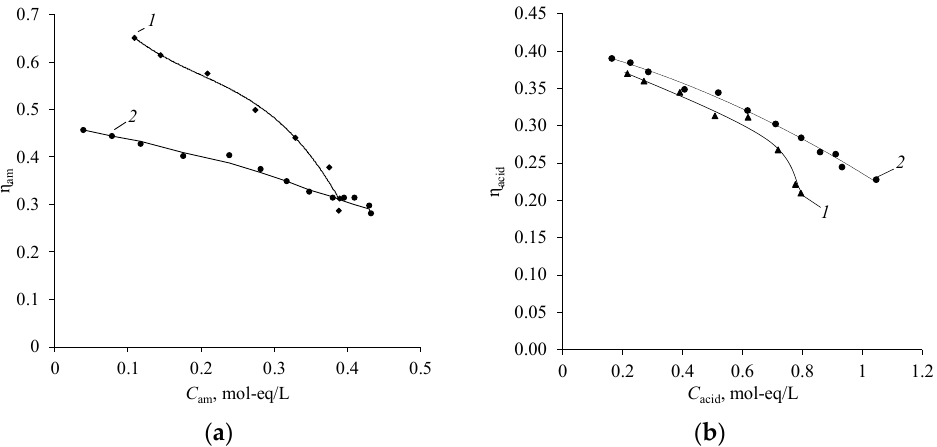
Figure 18. Concentration dependence of the integral current efficiencies of diethylamine ( a ) and sulfuric acid ( b ) used in the electrodialyzer as anion-exchange membranes: 1 —MA-40L, 2 —Ralex AMH. The solid lines show the approximating curves.